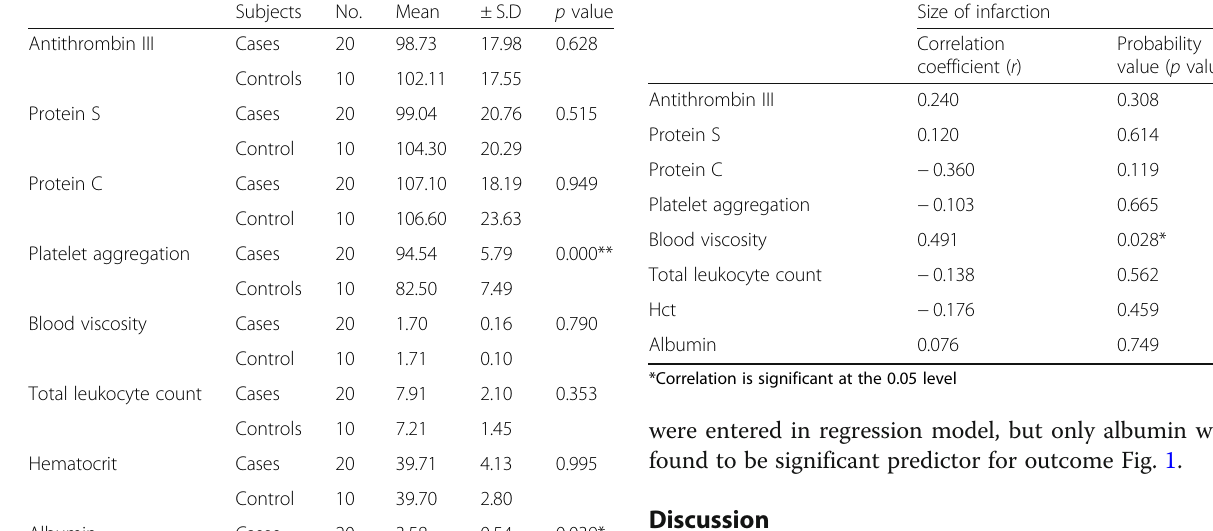
Table 5 Correlation between size of infarction and laboratory